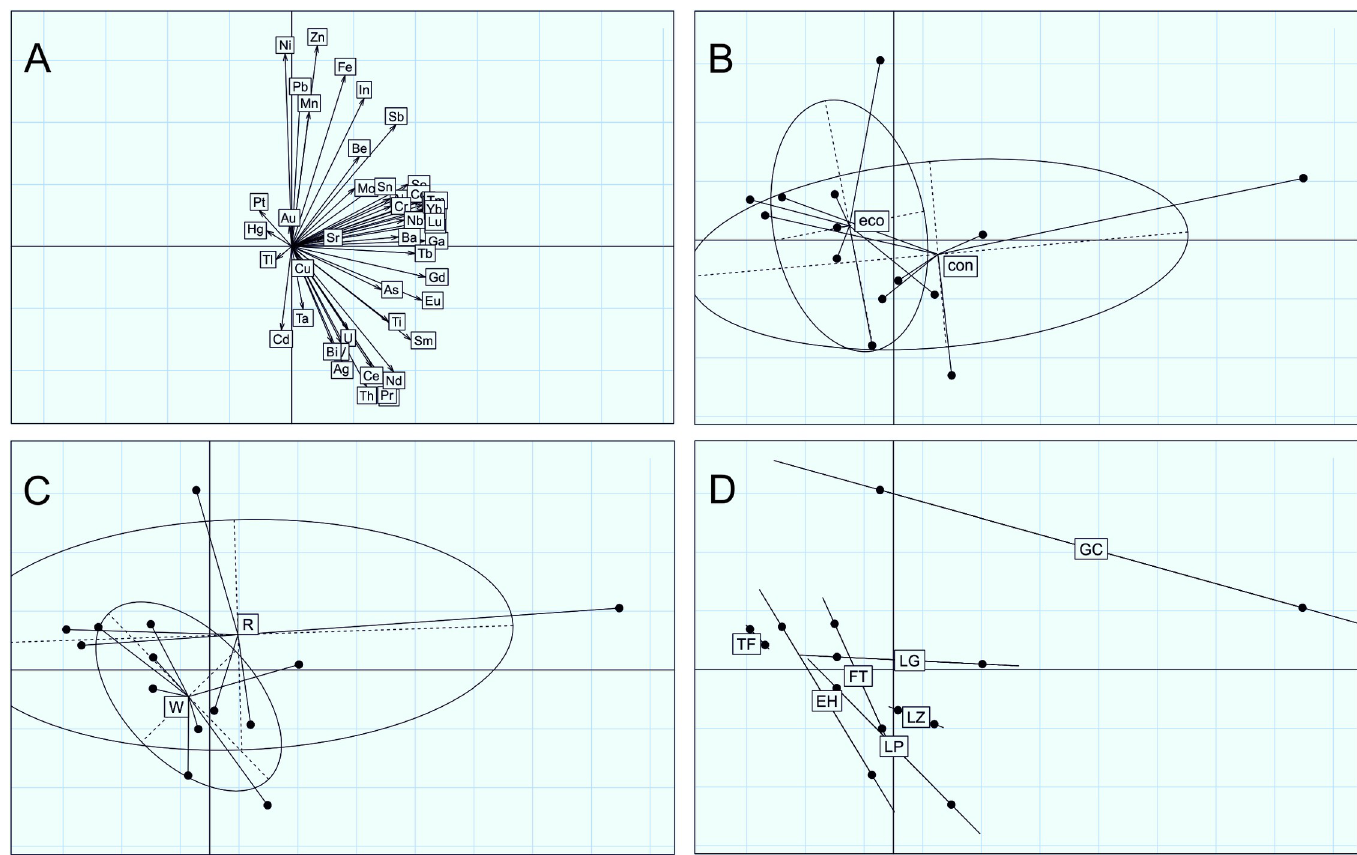
Fig 3. A-D. Principal components analyses ordinations of the wine samples according to the variation in metal concentration profiles. A) variable contribution to two main principal components and B, C, D) wine samples ordinations grouped by management type (conventional, con; organic, eco), type of wine (red, R; white, W) and the island of origin (El Hierro, EH; La Palma, LP; La Gomera, LG; Tenerife, TF; Gran Canaria, GC; Fuerteventura, FT; Lanzarote, LZ)